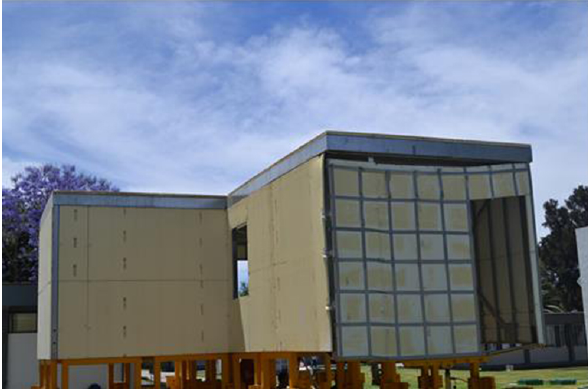
Figure 3. Structuring of housing and location of North and Central walls (SAP 2000,